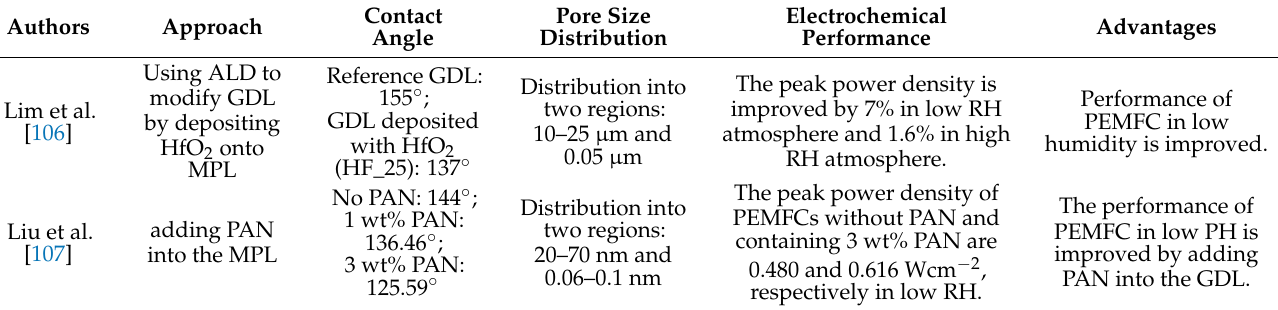
Figure 13. I–V curves and power densities of the PEMFCs with a reference GDL and that deposited with HfO 2 for 25 cycles (Hf_25) fed with hydrogen (RH 50%) and air with a relative humidity of ( a ) 0% and ( b ) 100%. Reproduced with permission [106]. Copyright 2021, Elsevier. Table 2. Summarization of improvement of GDL in recent years.